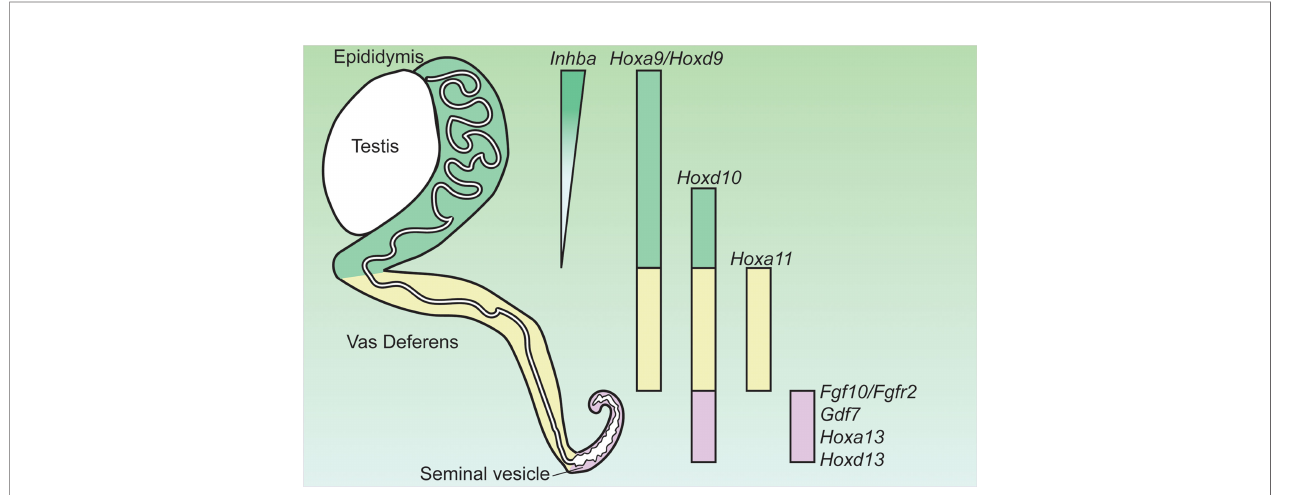
FIGURE 1 | Expression of genes critical for the regionalization of the Wolf fi an duct and potentially involved in region-speci fi c androgen actions. Hox, homeobox; Inhba, inhibin b A; Gdf7, growth differentiation factor 7; Fgf10, fi broblast growth factor 10; Fgfr2, fi broblast growth factor receptor 2. Adapted from